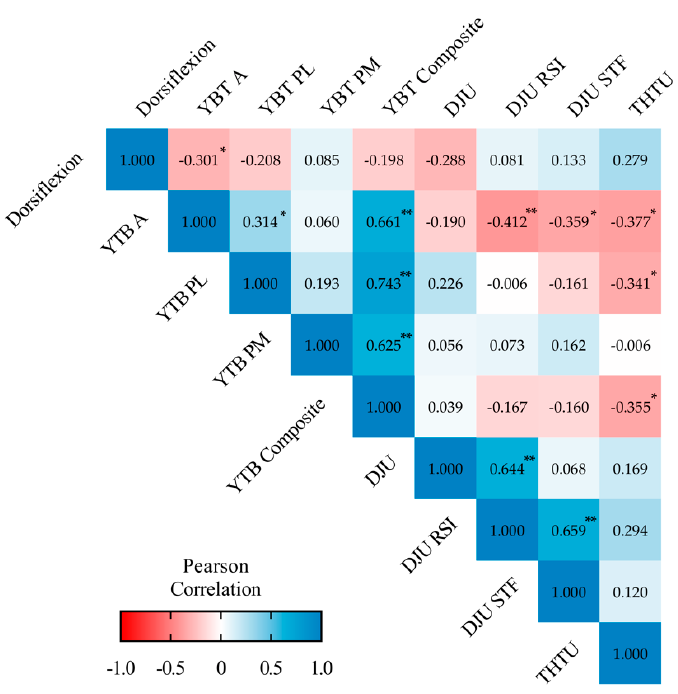
Figure 2. Matrix correlations (Pearson’s r, 95% confidence intervals) between the inter-limb asymmetry scores in functional tests and lower limb strength sports performance. The model was adjusted for age. *Statistical significance at p < 0.05. **Statistical significance at p < 0.01. YBT A—Y-balance test anterior reach; YBT PM—Y-balance test posteromedial reach; YBT PL—Y-balance test posterolateral reach; YBT—Y-balance test composite of all directions; DJU—drop jump unilateral; RSI—reactive strength index; STF—stiffness; THTU—triple hop test unilateral.